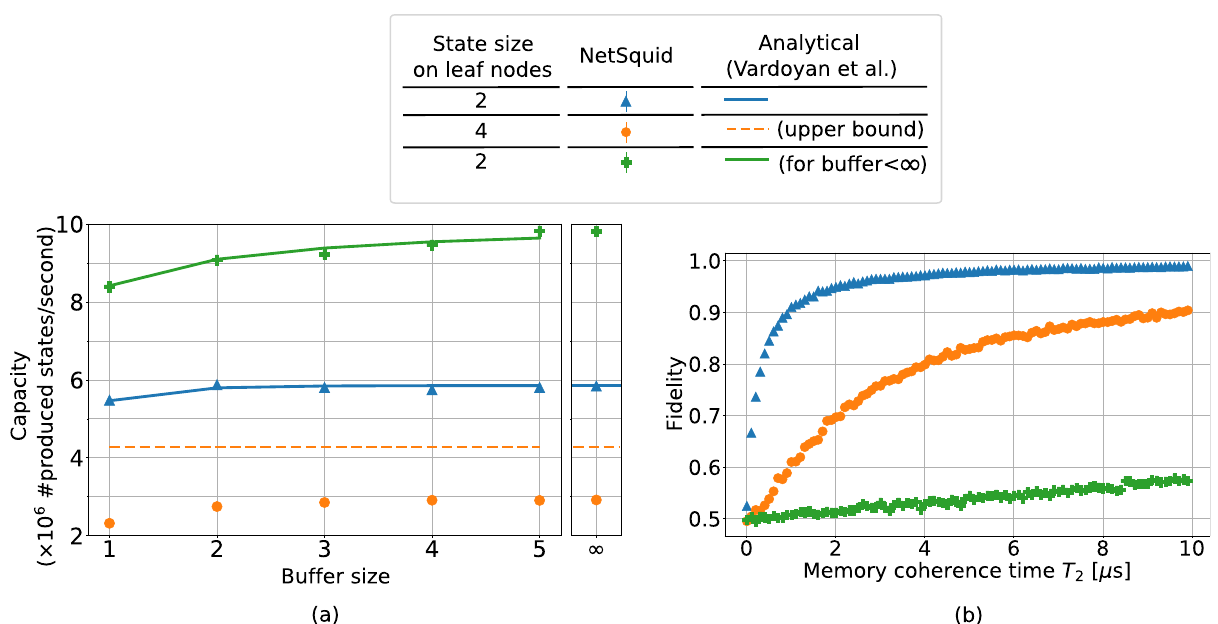
Fig. 4 Performance analysis of the quantum switch with nine users using NetSquid. a Capacity as a function of the buffer size (number of quantum memories that the switch has available per user) for either 2 − or 4 − qubit Greenberger – Horne – Zeilinger (GHZ)-states. For each scenario, the generation rate μ of pairs varies per user. For the blue scenario (2-partite entanglement, μ = [1.9, 1.9, 1.9, 1, 1, 1, 1, 1, 1] MHz), the capacity was determined analytically by Vardoyan et al. using Markov Chain methods 56 . Here we extend this to 4-partite entanglement (orange scenario, same μ s), for which Vardoyan et al. have found an upper bound (by assuming unbounded buffer and each μ = maximum of original rates = 1.9 MHz) but no exact analytical expression. The green scenario ( μ = [15, 1.9, 1.9, 1, 1, 1, 1, 1, 1] MHz) does not satisfy the stability condition for the Markov chain for unbounded buffer size (each leaf ’ s rate < half of sum of all rates) so in that case steady-state capacity is not well-de fi ned. We note that regardless of buffer size, the switch has a single link to each user, which is the reason why the capacity does not scale linearly with buffer size. b Average fi delity of the produced entanglement on the user nodes (no analytical results known) with unbounded buffer size. The fact that the green curve has lower fi delity than the blue one, while the former has higher rates, can be explained from the fact that the protocol prioritises entanglement which has the longest storage time (see Supplementary Note 3). Each data point represents the average of 40 runs (each 0.1 ms in simulation). Standard deviation is smaller than dot size.